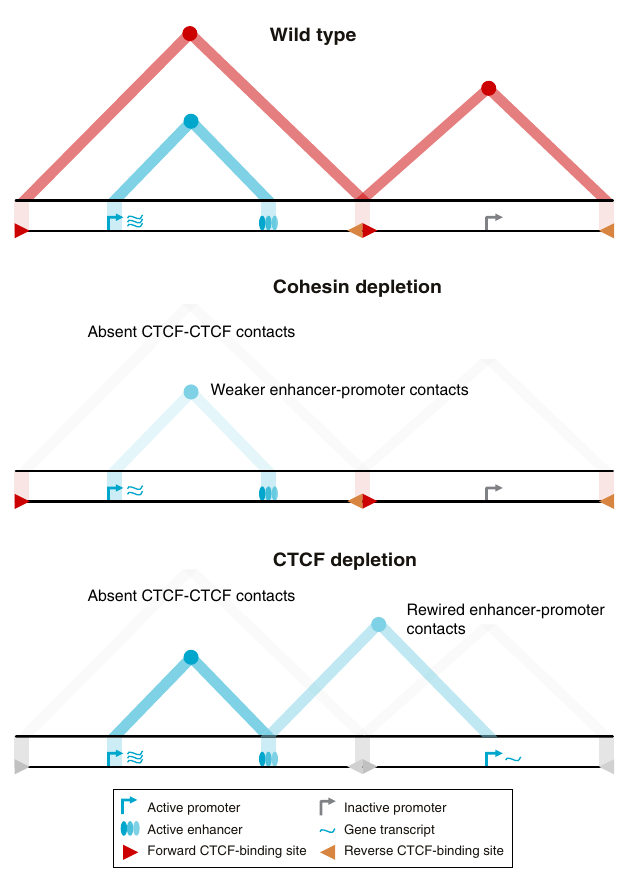
Fig. 7 Graphical summary. The top panel shows topologically associating domains (TADs; red triangles), interactions between their CTCF boundaries (red circles at the apexes of the TADs), and enhancer – promoter interactions (blue circle at the intersection between the active promoter and enhancer, as indicated with the light blue triangle) for a hypothetical region of the genome in wild-type cells. Upon cohesin depletion (middle panel), TADs are weakened, interactions between CTCF-binding elements are lost, and interactions between active enhancers and promoters are decreased, causing small changes in gene expression. Depletion of the CTCF protein (bottom panel) causes a loss of TADs and CTCF-mediated interactions but does not generally reduce enhancer – promoter interactions. Depending on the context, however, CTCF depletion can result in the formation of ectopic enhancer – promoter interactions and changes in gene